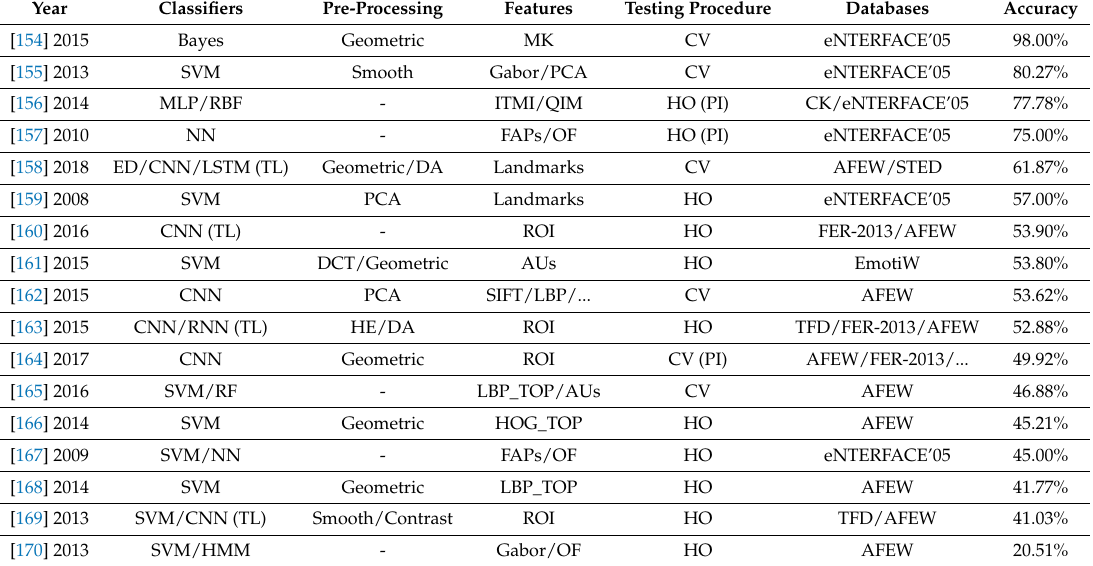
Table 4. Results of reviewed works for audiovisual approaches.